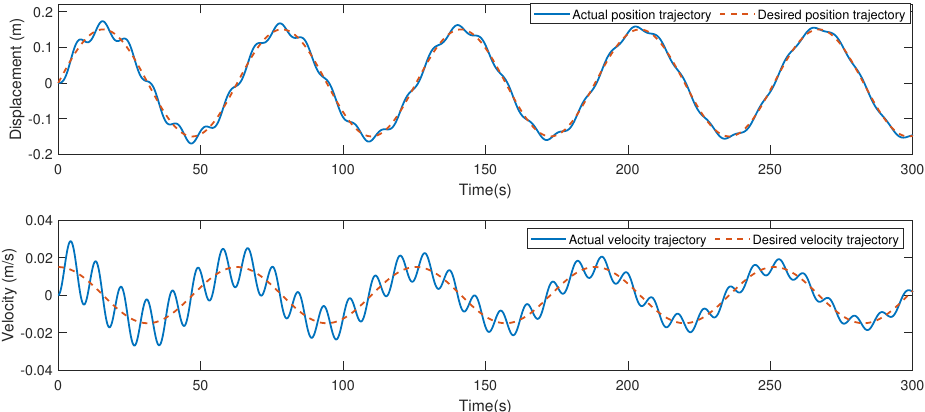
Figure 15. The position and velocity trajectory of the